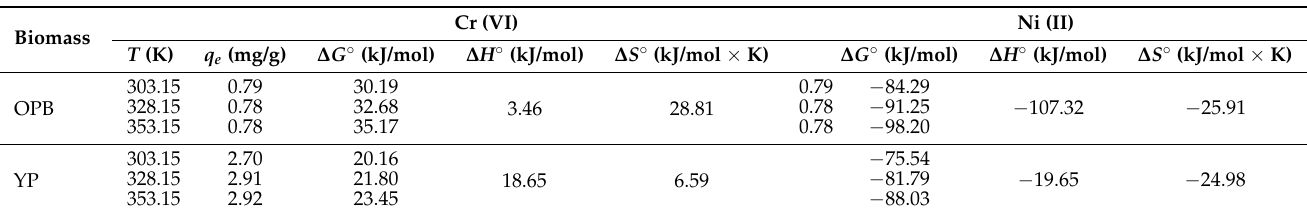
Table 7. Thermodynamic parameters for chromium (VI) and nickel (II) adsorption at bed height of 65